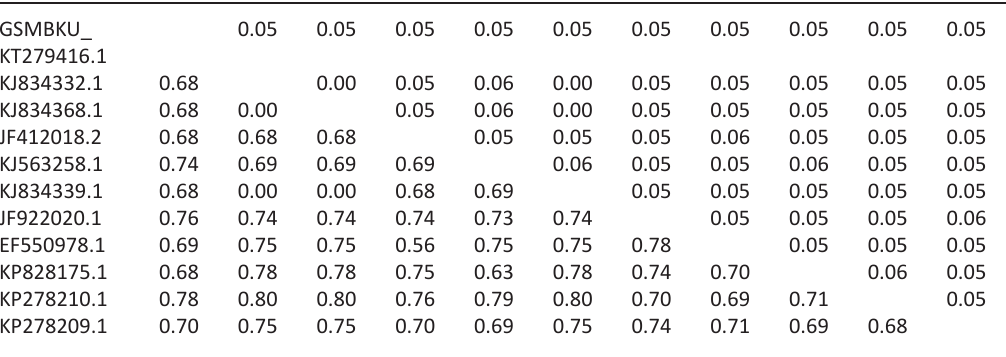
Table 1. Distance matrix